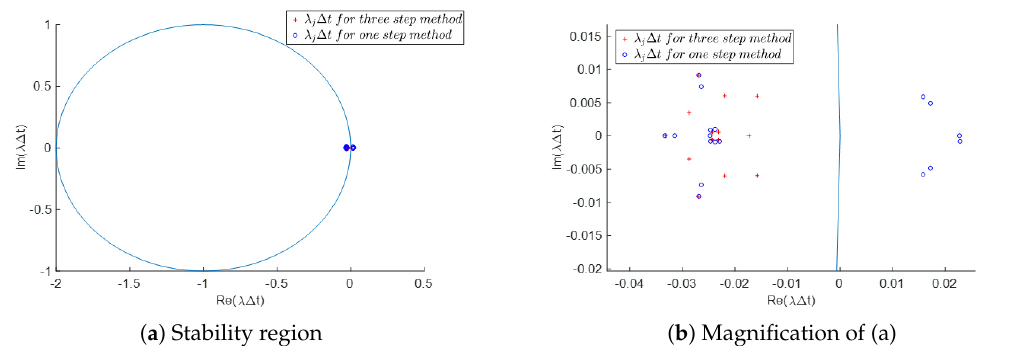
Figure 4. Stability region of Example 2 with the position of λ j ∆ t for M = 8, K = 1 and ∆ t = 0.006. ( b ) is obtained from the magnification of ( a ).